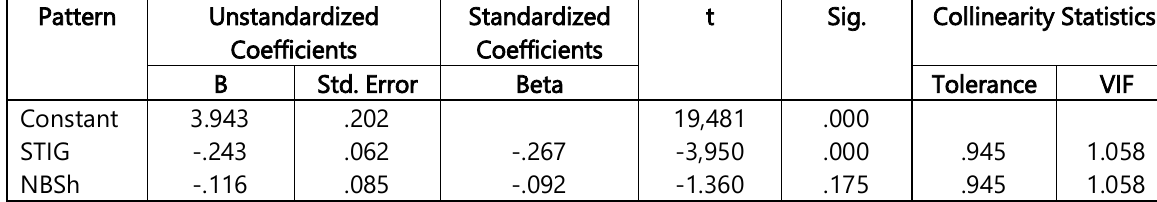
Table 13: Regression Coefficients of the Independent Variables (Source: Authors’ calculation) Pattern Unstandardized Standardized t Sig. Coefficients B Std. Error VIF Constant 3.943 STIG -.243 NBSh -.116